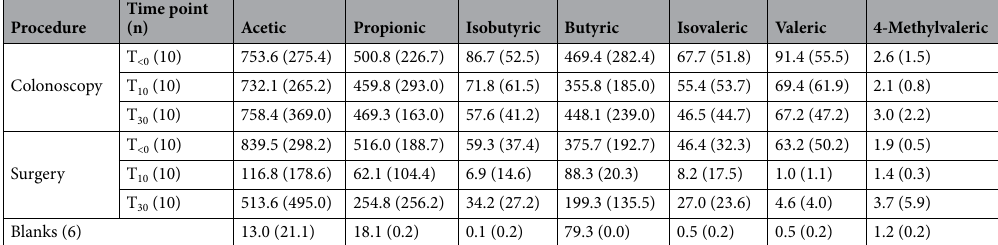
Table 4. Concentrations as mean (SD) of SCFA